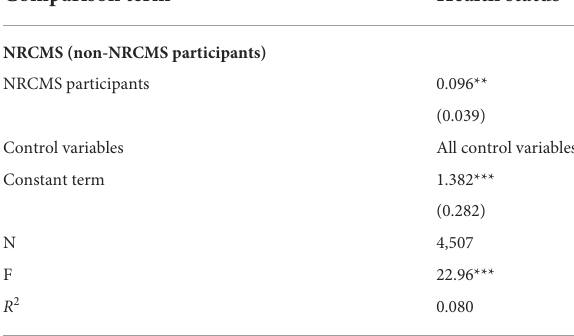
TABLE 2 OLS regression results of the health level of the relatively poor population in rural